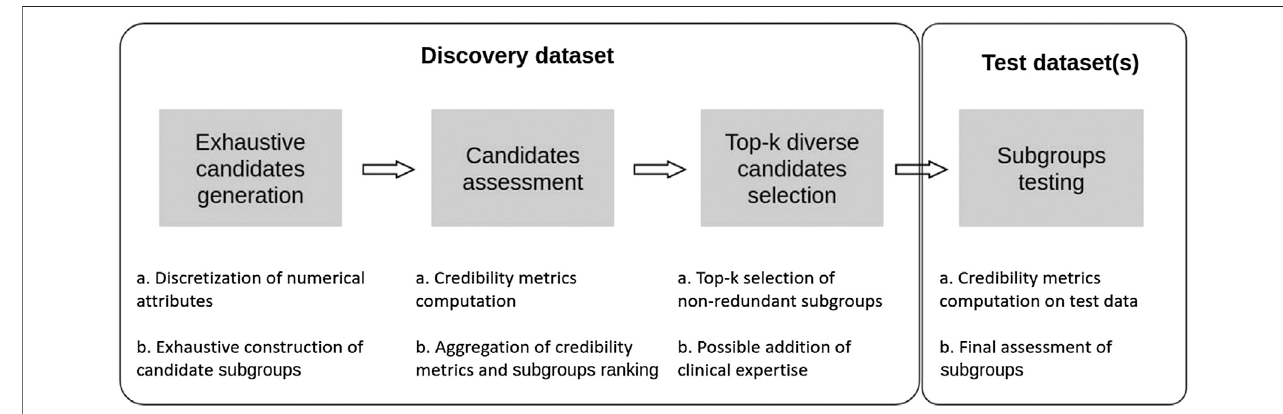
FIGURE 4 | Q-Finder works in 4 main stages: an exhaustive generation of candidate subgroups, a ranking of candidate subgroups via an evaluation of their empirical credibility, a selection of the best candidates (taking into account the redundancy between subgroups), and then an assessment of subgroups ’ credibility on one or more test